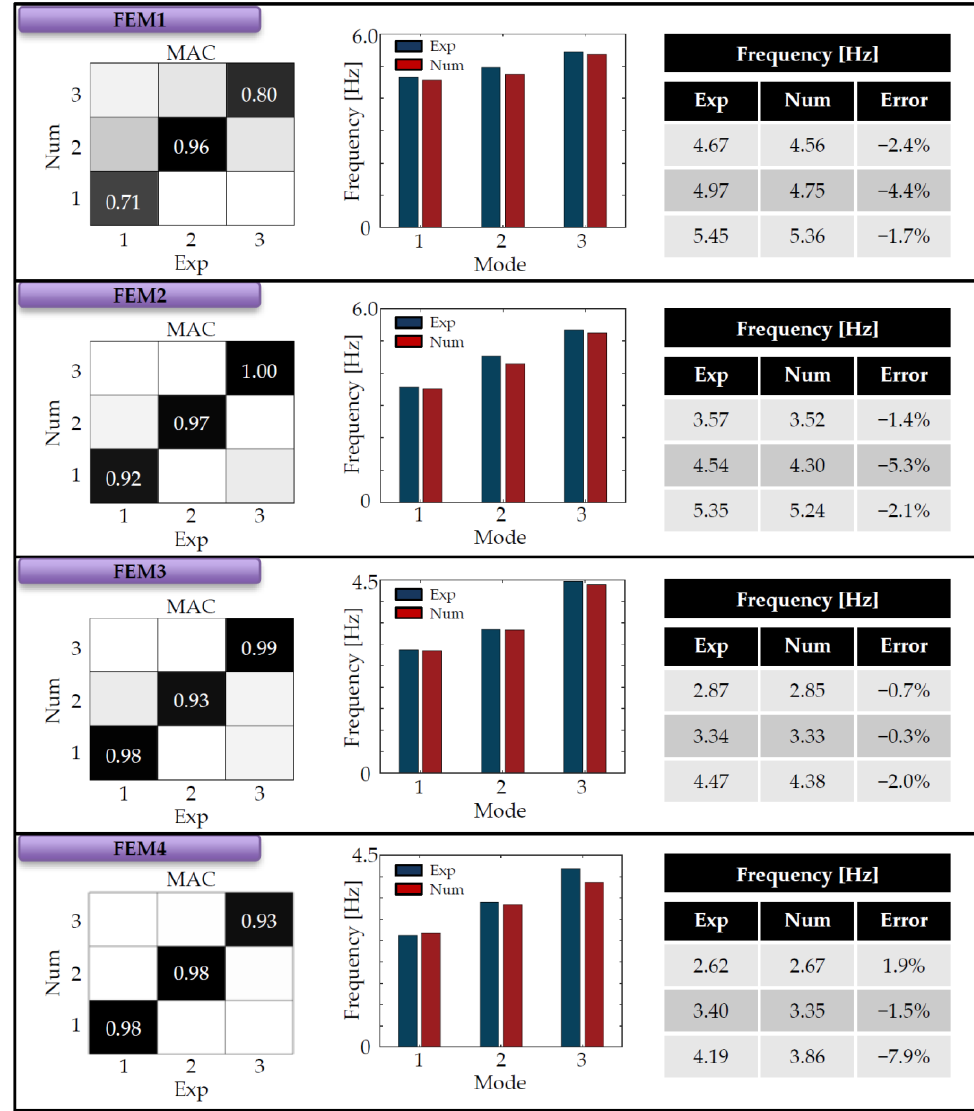
Figure 10. Comparison between experimental and numerical modal parameters after the updating — Part 1/2.